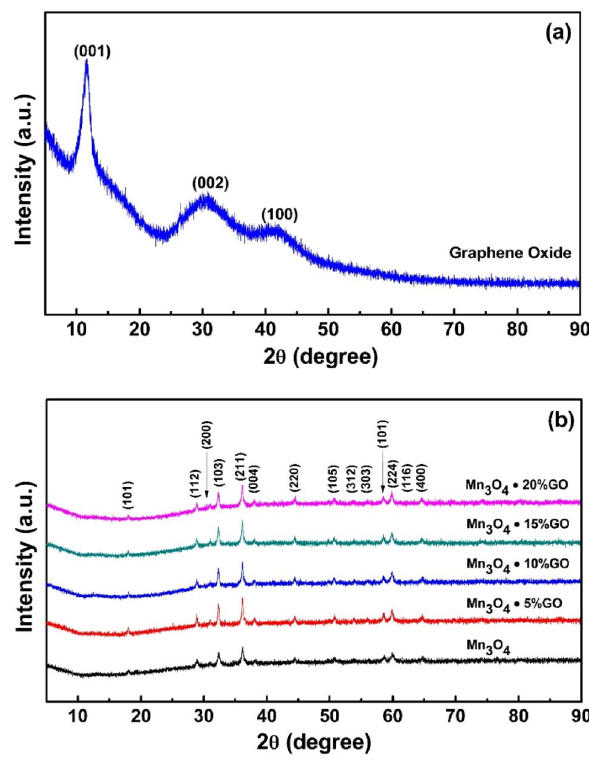
Fig. 1 X-Ray Diffraction Patterns of a Graphene oxide and b Mn